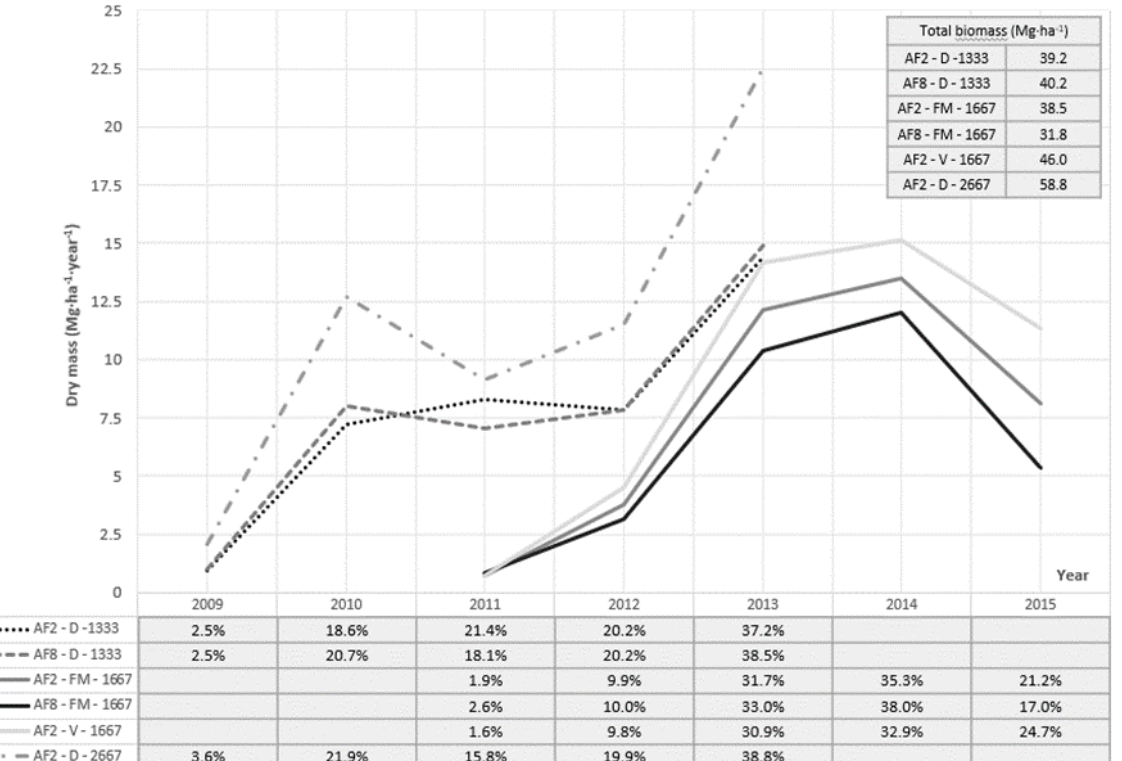
Figure 2. The annual accumulation of dry biomass and its share of the total yield considering the different densities, clones, and crop location (FM–F â nt â na Mare; V–Vics values from the table below the graph show the cumulative biomass percentage of each growing season from the total, and the table on the top right shows the total biomass at the end of the five growing